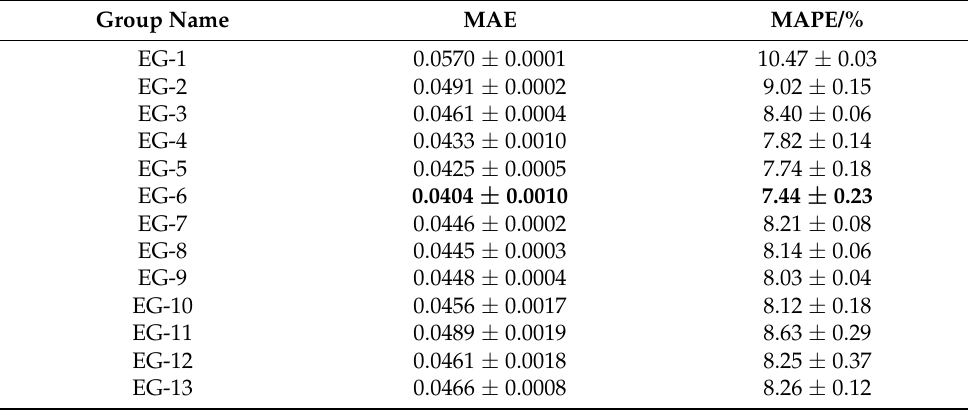
Table 2. The experimental results table of variable selection.